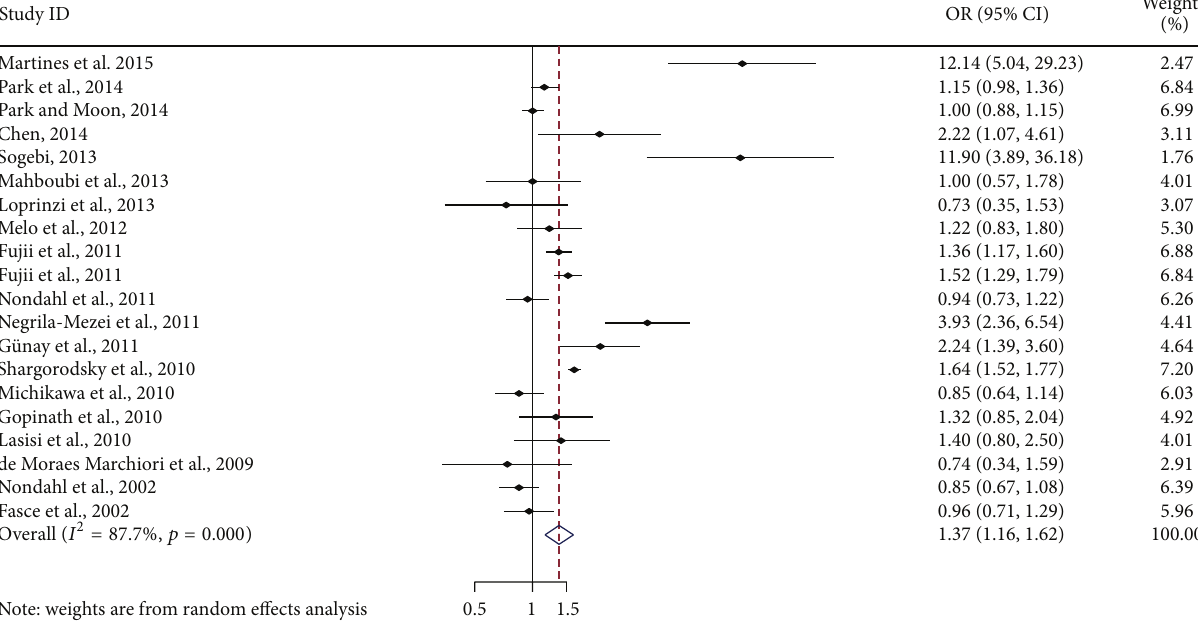
Overall ( I 2 = 87.7%, p = 0.000 )